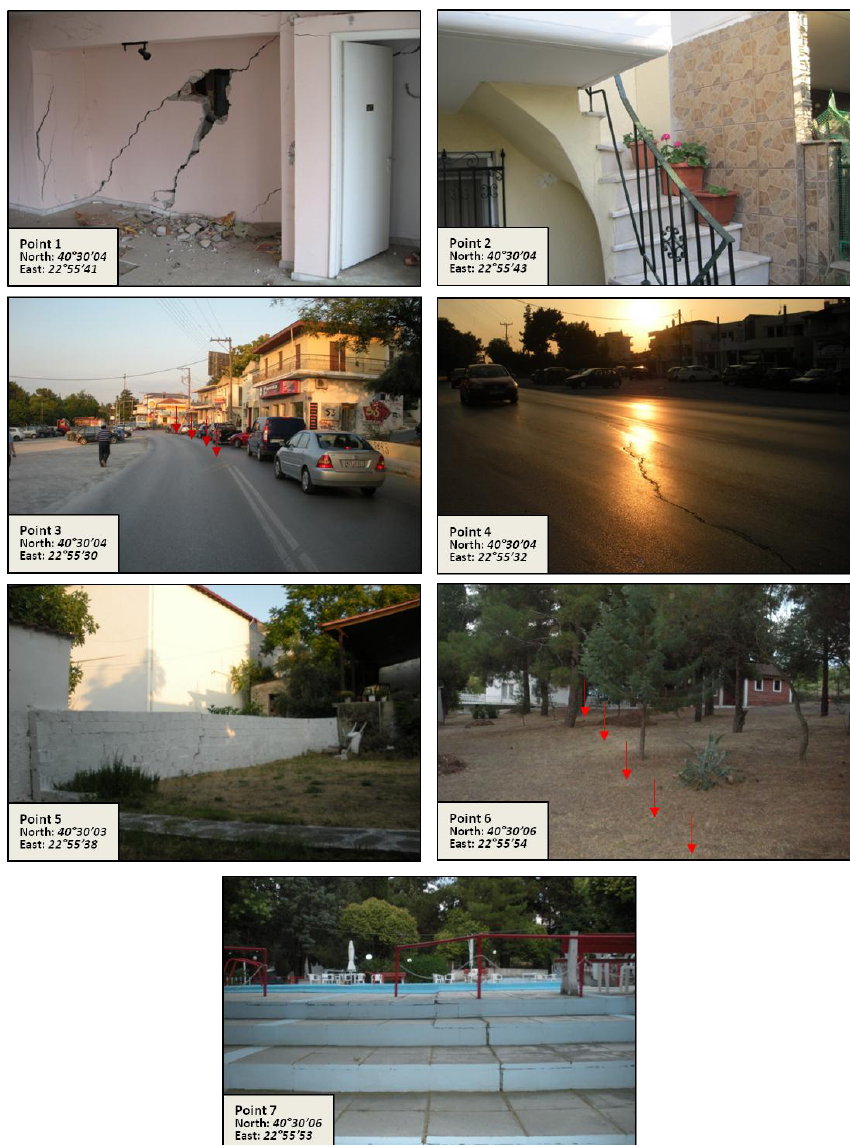
Figure 11. Field evidences of ground ruptures in Perea. Coordinates are in UTM WGS 84 (projected). Damages witnessed at buildings (points 1&2), streets pavement (points 3&4), light constructions (points 5&7) and natural terrain (point 6).